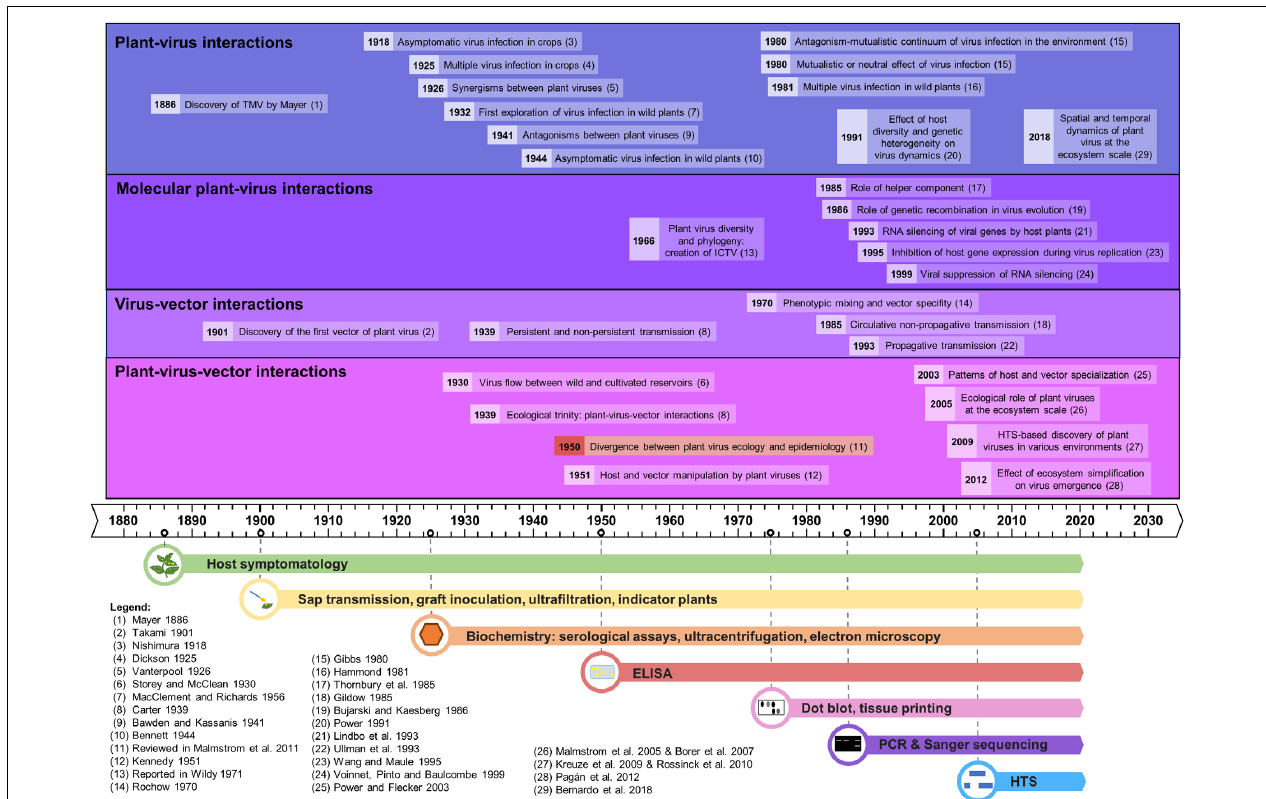
FIGURE 1 | Time line of the major advances in plant virus ecology, linked to the evolution of the detection methods.